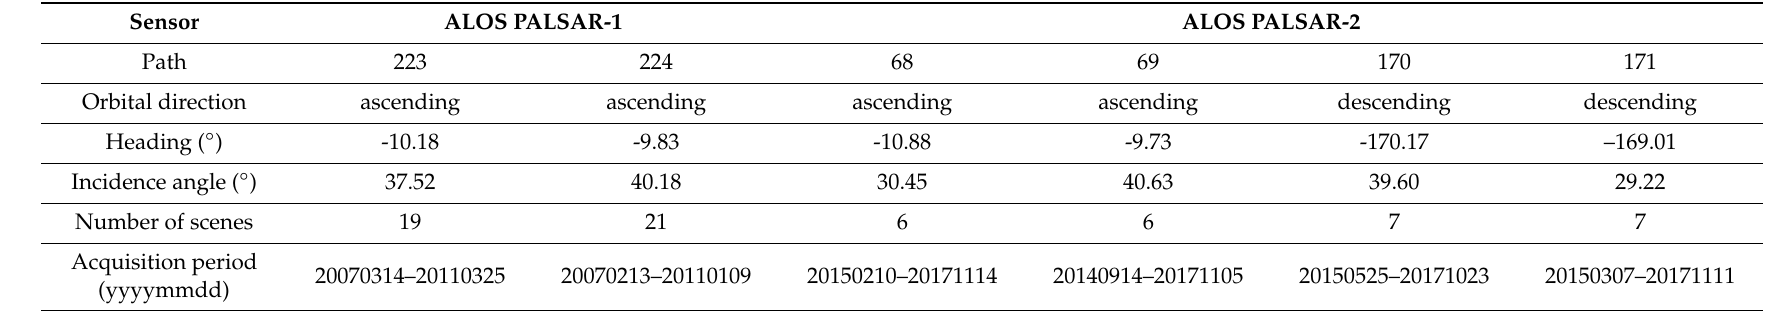
Table 1. The detailed parameters of the synthetic aperture radar (SAR) datasets used in this